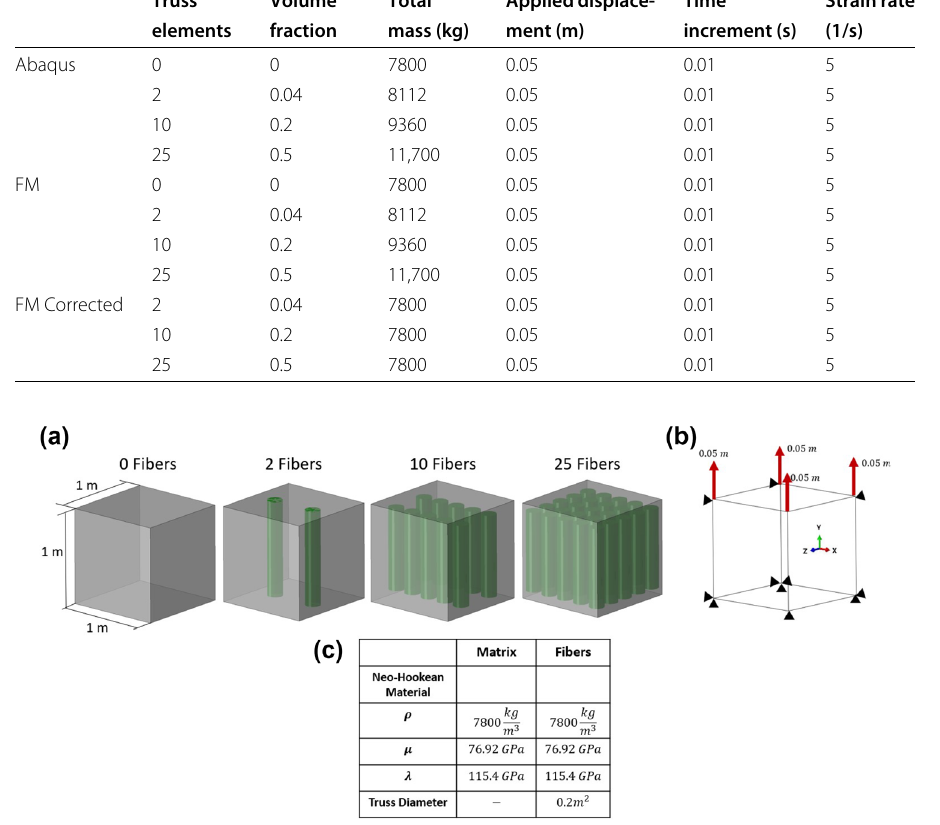
Table 1 Fiber volume fraction dependency tests